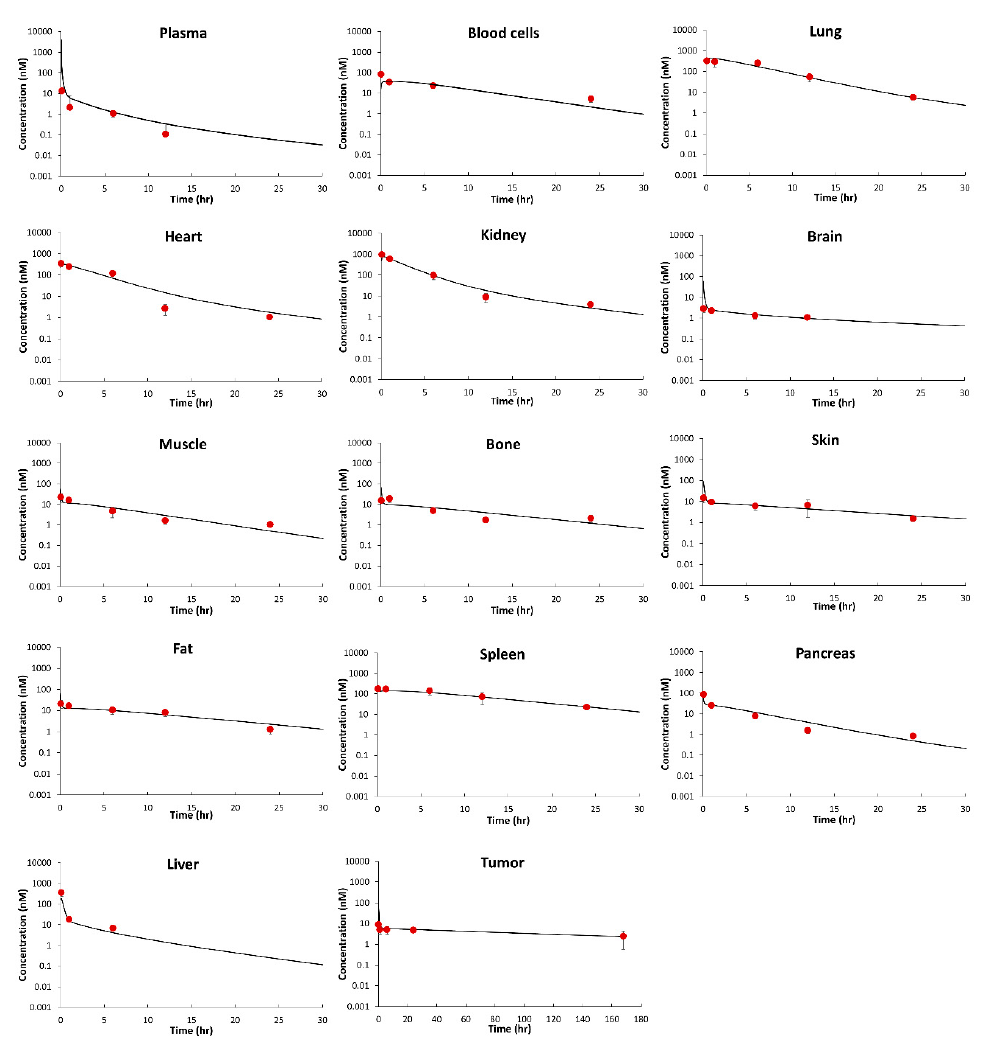
Figure 3. Comparison of PBPK model fitted and observed PK profiles of MMAE. The figure displays observed (dots) and model predicted (solid lines) plasma, tissues, and tumor concentration vs. time profiles of MMAE in mice after intravenous administration of 0.1 mg/kg dose.